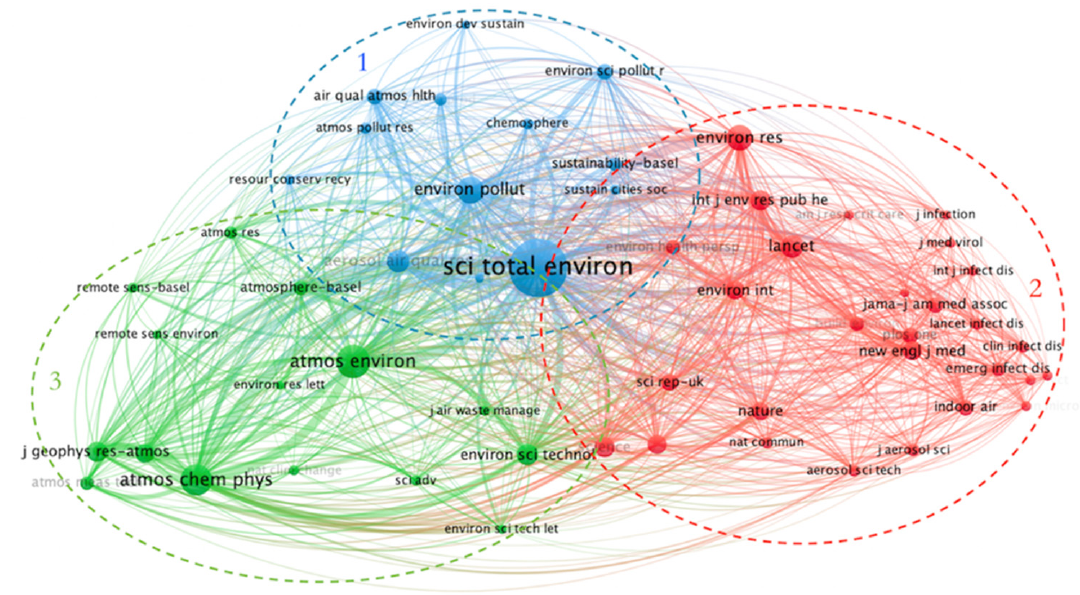
Figure 5. Journal co-occurrence chart. Table 2. The top 10 most active journals in terms of publication.